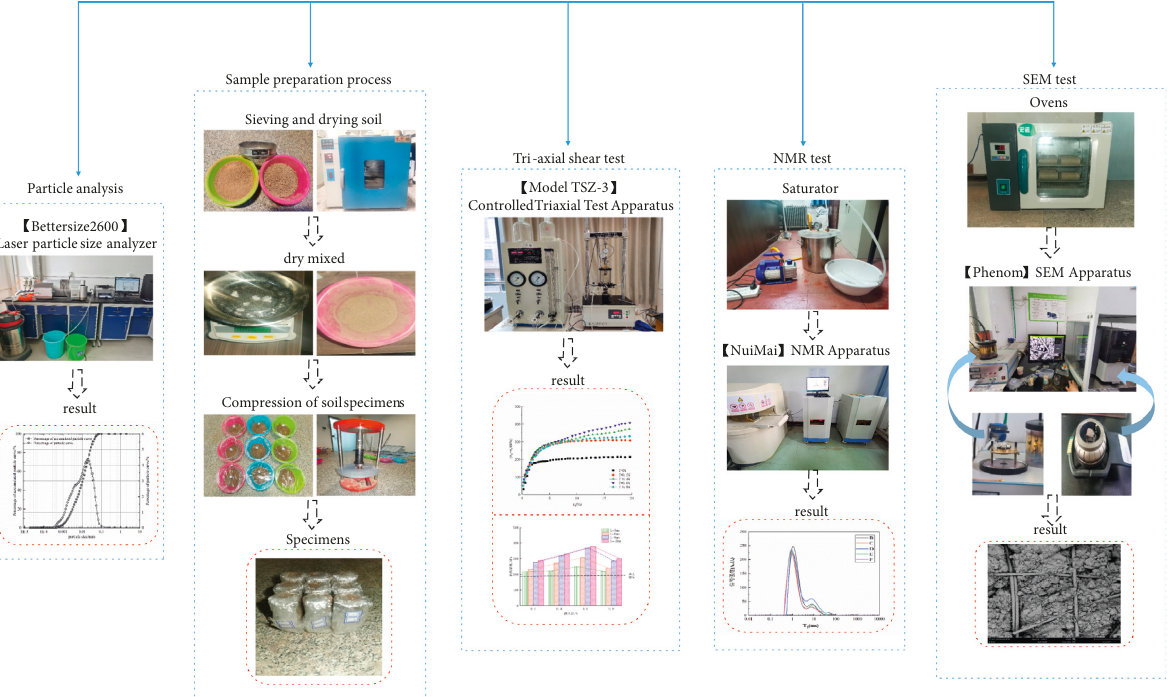
Figure 5: Experimental flow